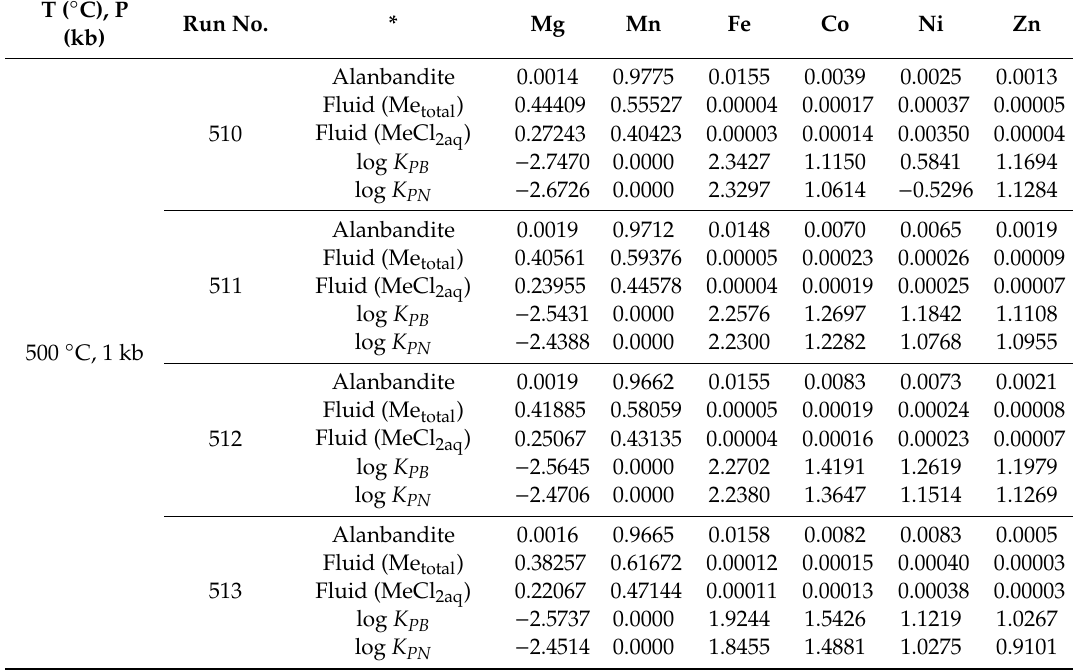
Table 2. Experimental results for the MnS–(Ni, Mg, Co, Zn, Fe)Cl 2 –H 2 O system at 500–800 ◦ C and 100